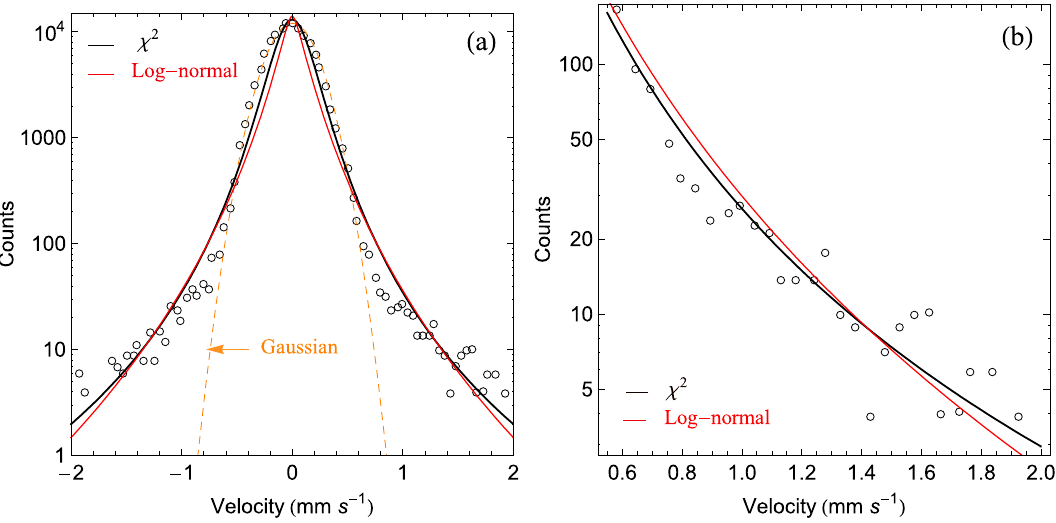
2 (black) and log-normal (red)